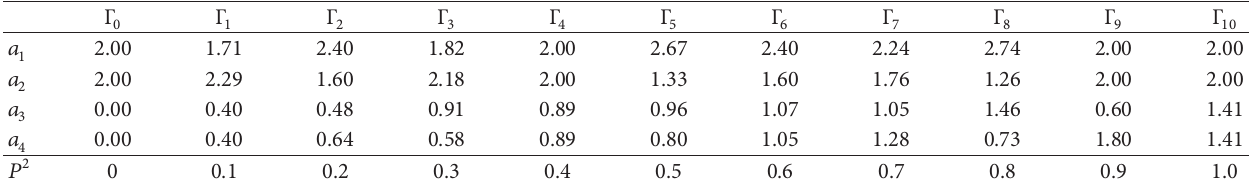
Table 1: Covariance matrix elements and square DoP values for the Jones vector.